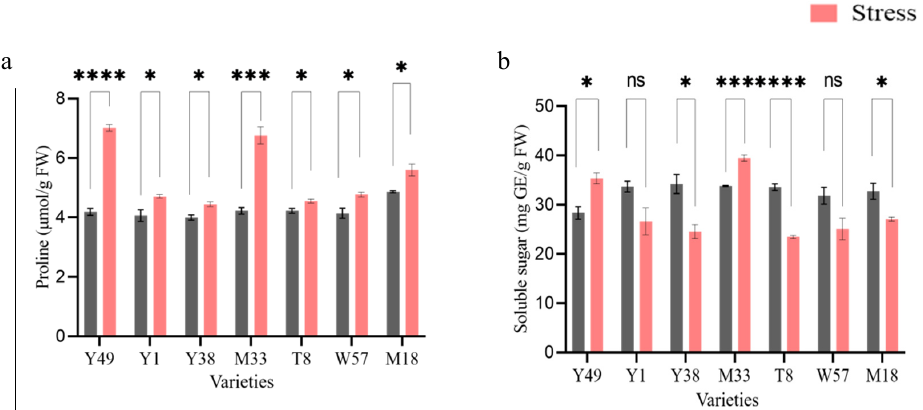
Figure 2. Response of jute varieties to low temperature treatments, with control (28 °C) and stress (5 °C) showing differential response in osmolyte content. ( a ) Proline content, ( b ) Soluble sugar content. Different significant level marked with **** p < 0.0001, *** p ≤ 0.001, * p ≤ 0.05, and ns mean